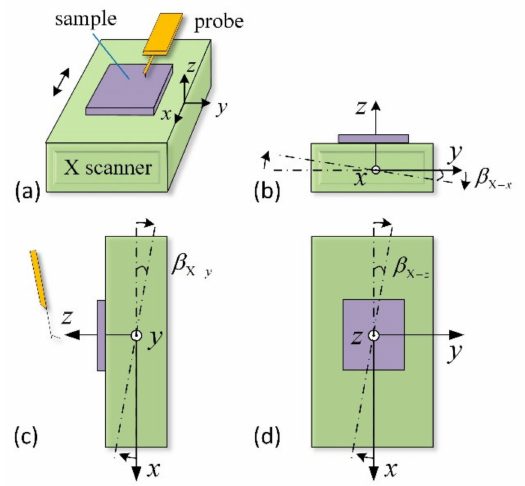
Figure 2. Installation error of the X-scanner. ( a ) Normal installation diagrams. Installation diagrams of an X-scanner installed obliquely around the x -axis ( b ), around the y -axis ( c ), and around the z -axis ( d